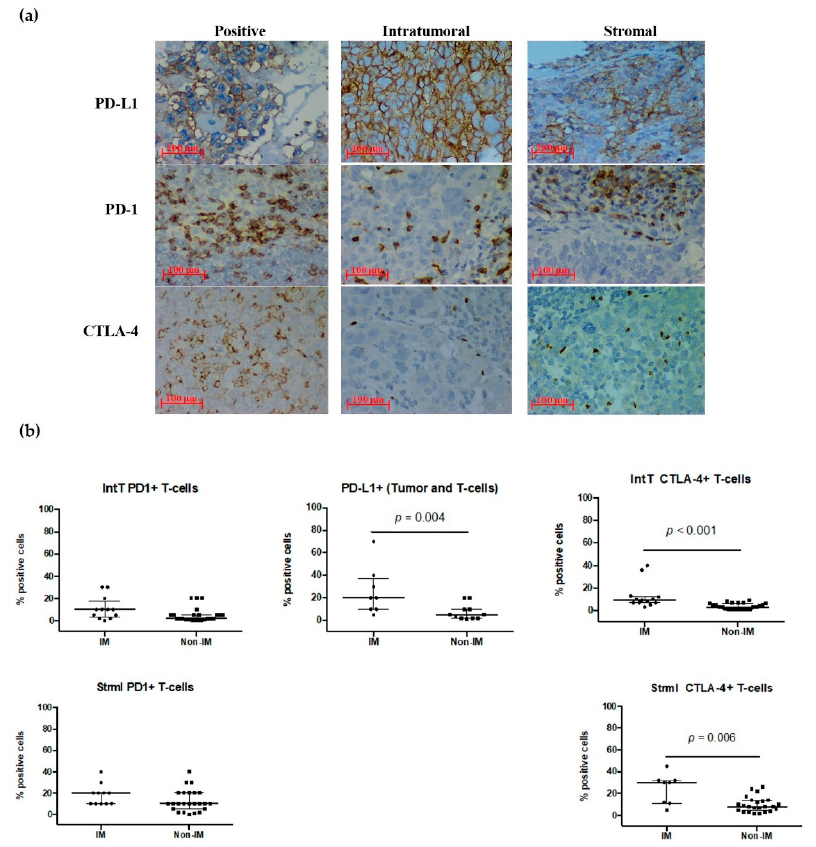
Figure 4. Expression of immune checkpoints in IM vs. non-IM subtypes. ( a ) Immunohistochemistry images of both intratumoral (intT) and stromal (strml) immune checkpoints (ICp) [PD-L1+ (ctrl ×40, intT ×40, strml ×40); PD-1+ (ctrl ×40, intT ×40, strml ×40), and CTLA-4+ (ctrl ×40, intT ×40, strml ×40)] in TNBC biopsies. ( b ) Scatter plots (percentages) comparing median and data distribution between IM vs. non-IM subtypes, both intT and strml per ICp positive cells (with interquartile range bars and the median); differences assessed using the Mann–Whitney U test; statistically significant differences are shown in each plot. Ctrl: controls.